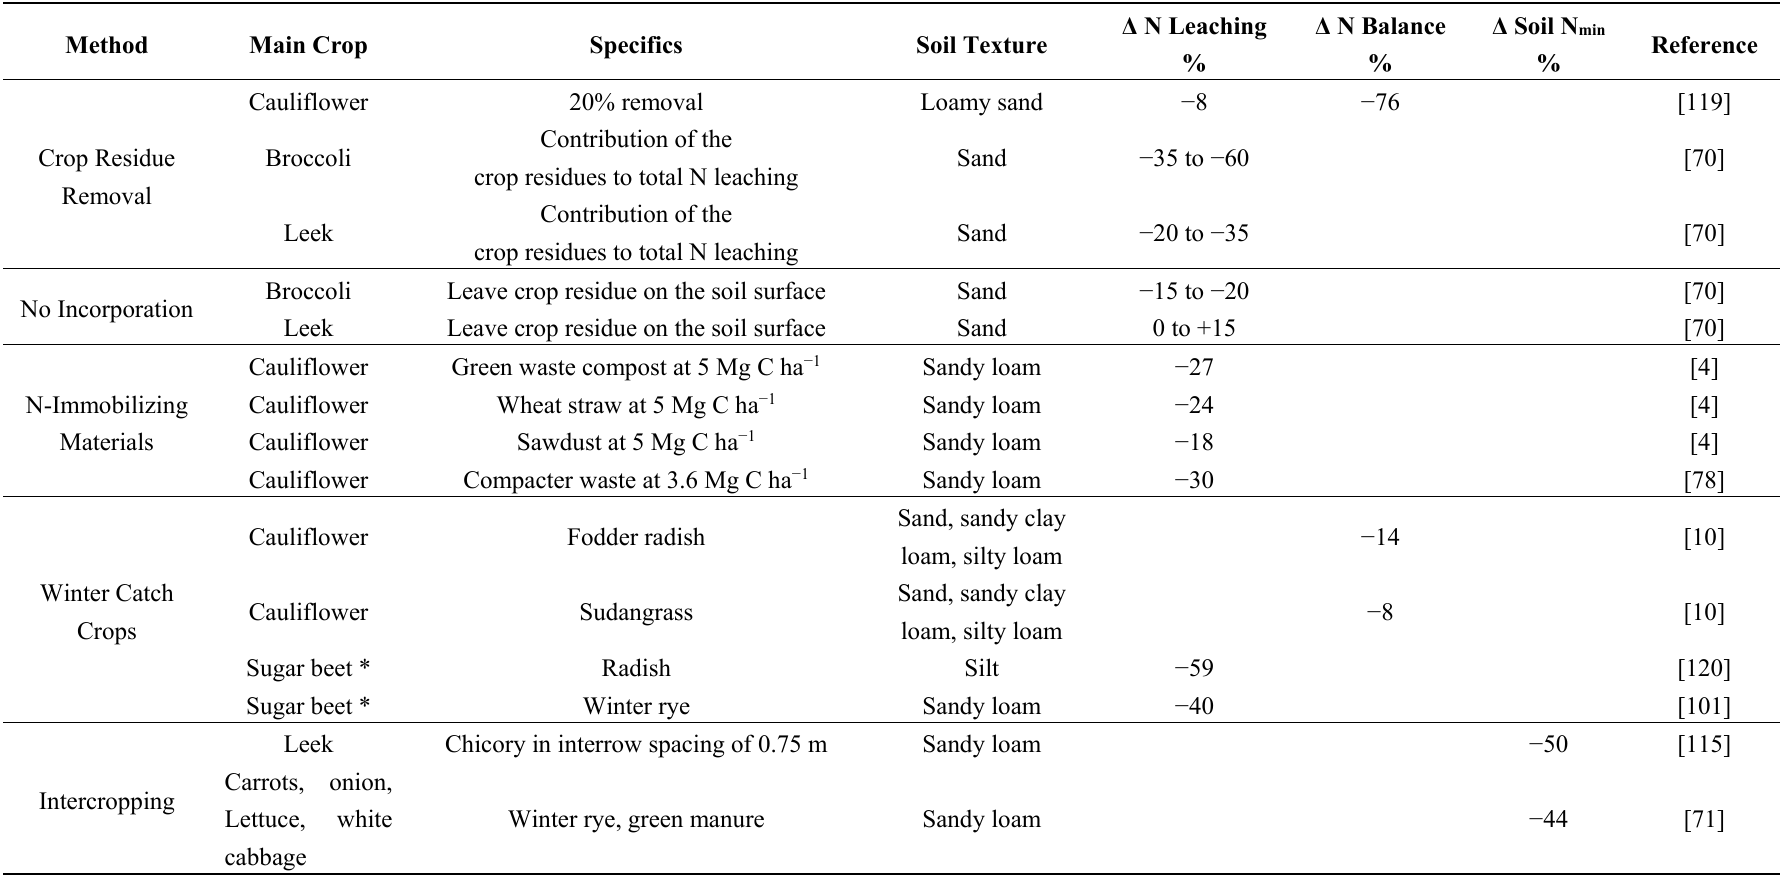
Table 3. Relative reduction in nitrate leaching (Δ leaching), N balance (ΔN balance) or soil mineral N content (Δ Soil N min ) as a consequence of alternative management options in intensive vegetable rotations compared to conventional practice (incorporation of crop residues; no winter catch crop or